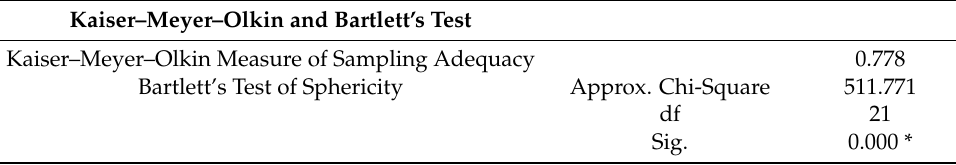
Table 2. The test results of the Kaiser–Meyer–Olkin test and Bartlett’s test of sphericity. Kaiser–Meyer–Olkin and Bartlett’s Test Kaiser–Meyer–Olkin Measure of Sampling Adequacy 0.778 Bartlett’s Test of Sphericity Approx. Chi-Square 511.771 df 21 Sig. 0.000